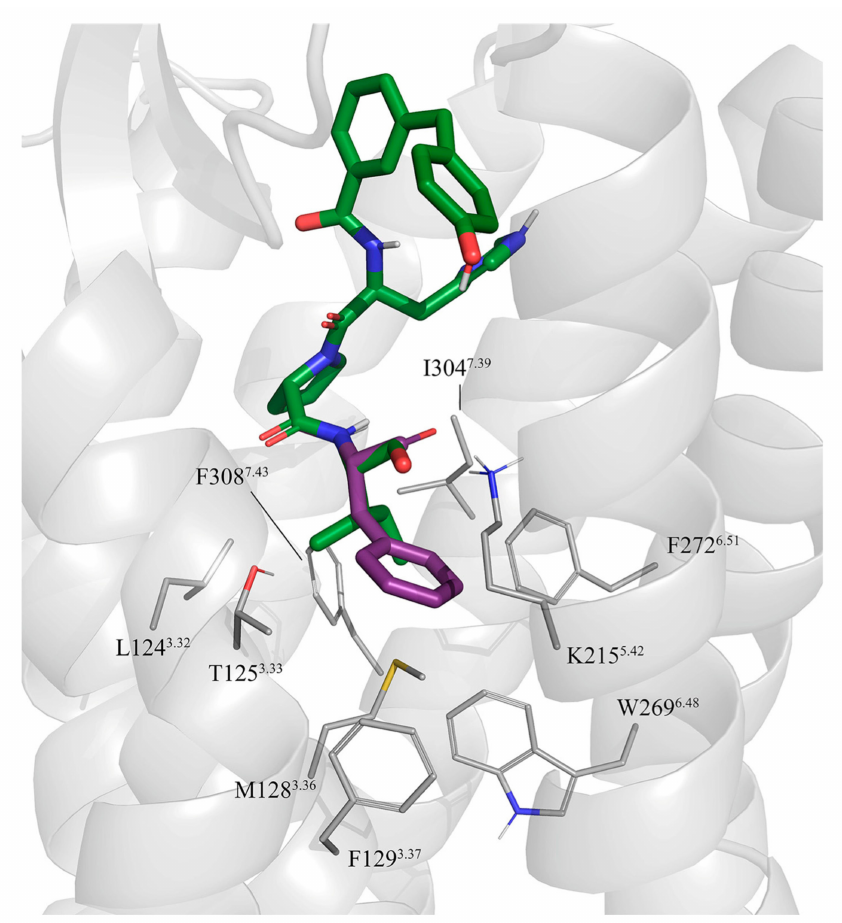
Figure 5. Comparison of the binding mode of 9 (purple sticks) and 10 (dark green sticks), with depiction of the sidechains surrounding the C-termini. The di ff erent orientations of the Ile / Phe could explain the change in a ffi nity observed for these two compounds.